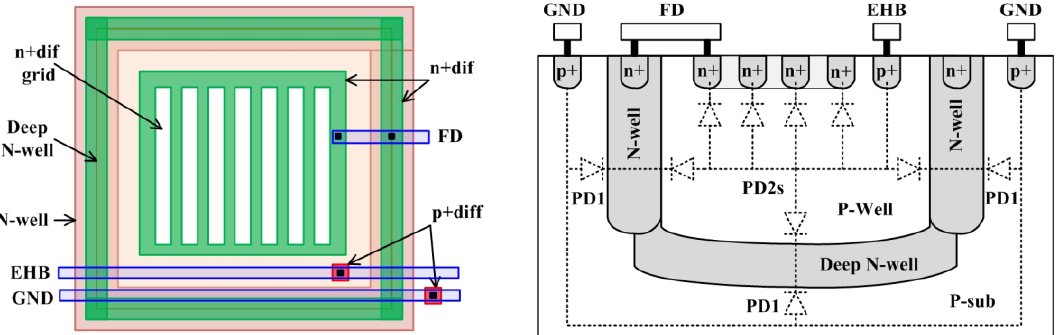
Figure 3. Proposed EHI CMOS APS pixel: ( a ) layout; ( b ) cross